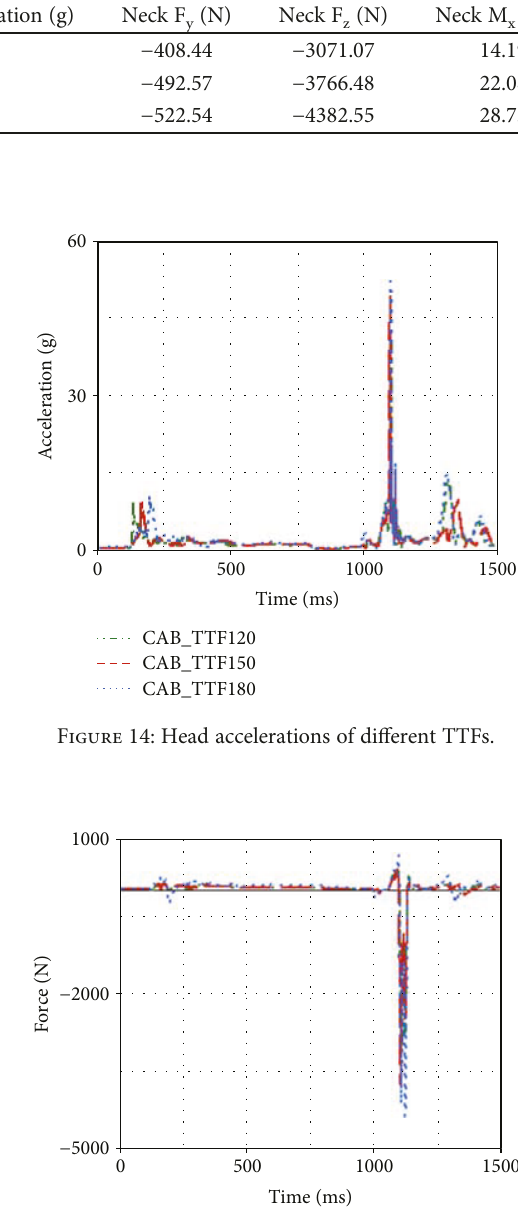
of di ff erent z